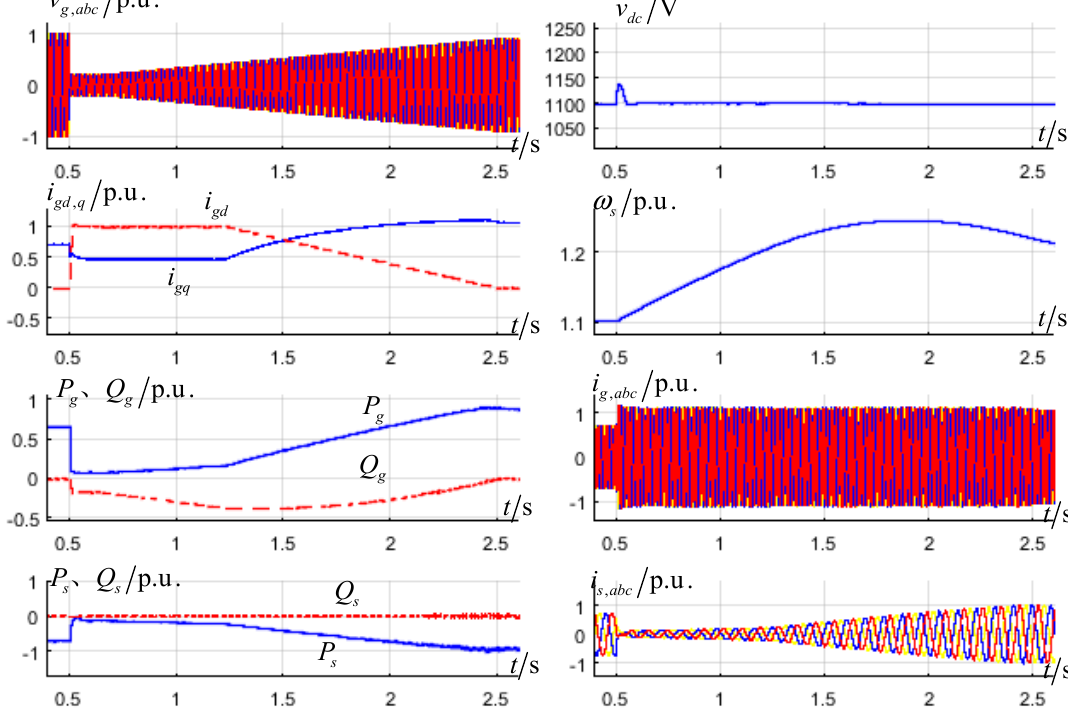
Figure 11. Simulation results of the voltage dips by the propose method used in the paper.